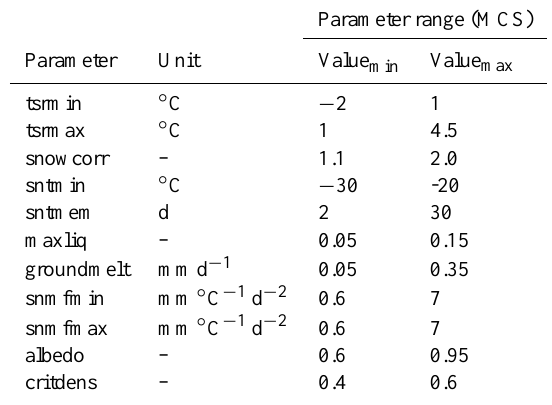
Table 1. Varied snow relevant parameter of HQsim by Monte Carlo Simulation. A description of parameters can be found in Sect.